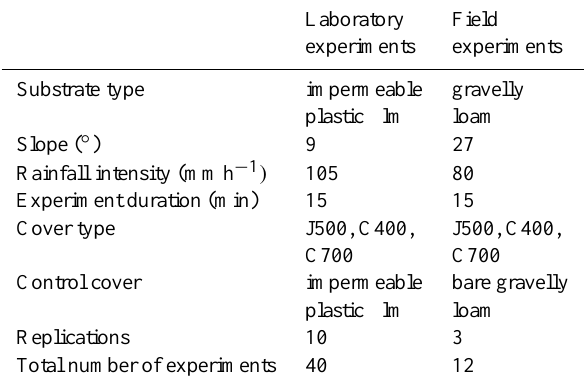
Table 3. An outline of laboratory and field experiments testing the impact of biological GTXs on surface run-off and soil loss.